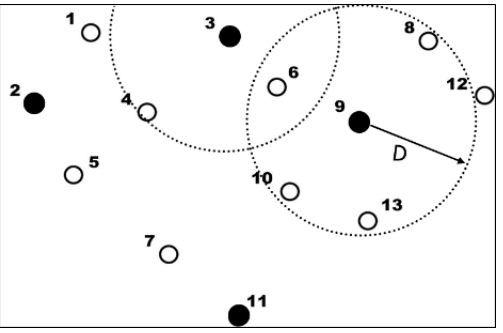
Figure 8. Simple example of reengineering restrictions. The black filled nodes represent currently deployed centers and the other nodes are used as candidate locations.